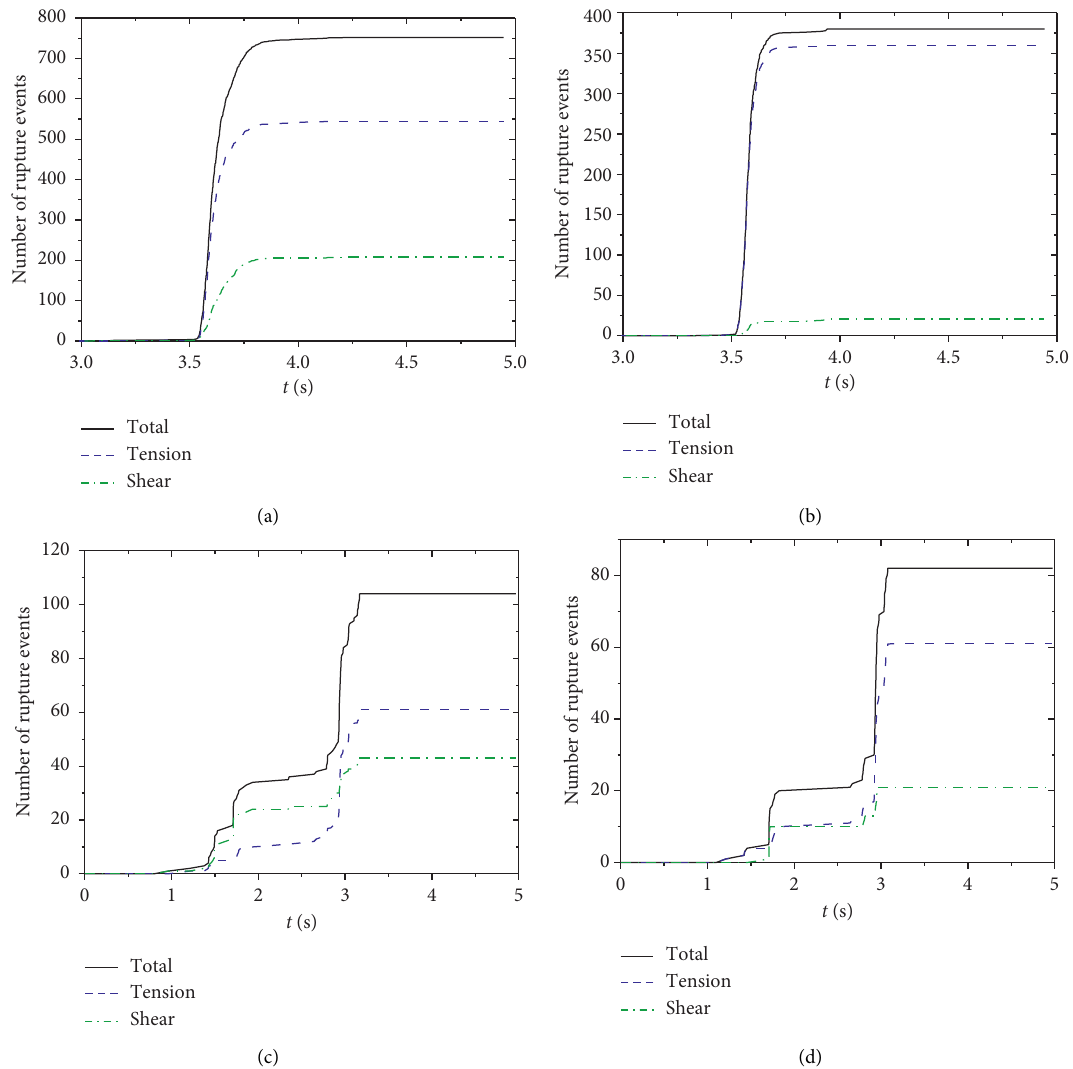
Figure 22: Cumulative failure process over time. (a) Slope with a weak interlayer under fling step ground motion. (b) Homogeneous slope under fling step ground motion. (c) Slope with a weak interlayer under pulseless ground motion. (d) Homogeneous slope under pulseless ground motion.